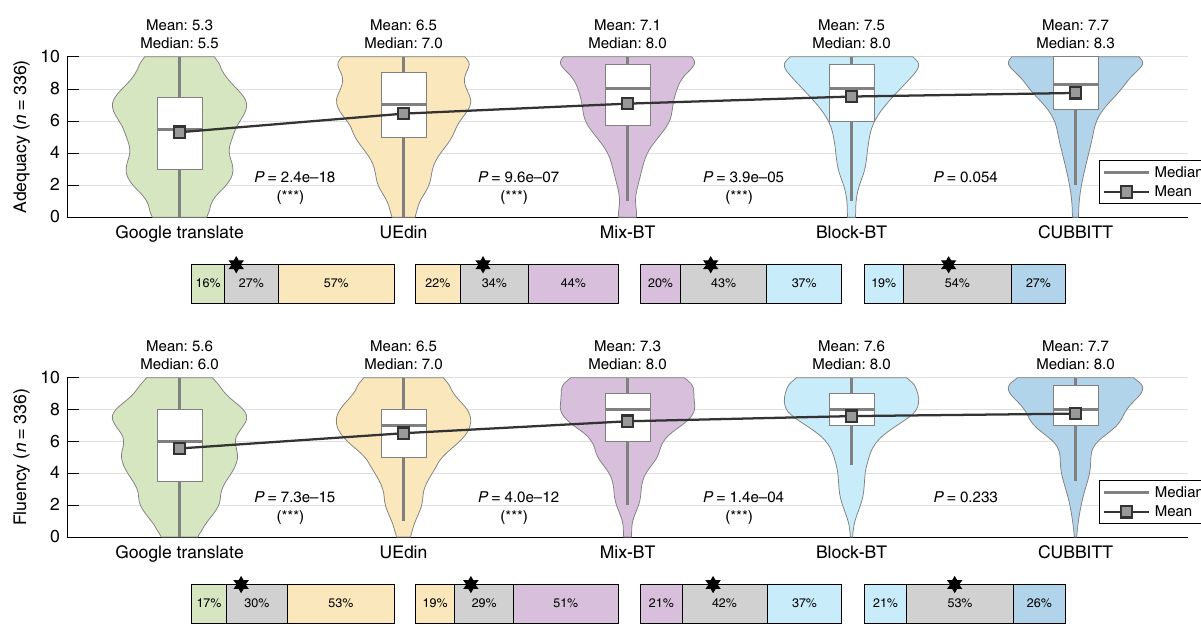
Fig. 4 Types of errors made by CUBBITT versus human and a comparison of machine systems. a Percentages of sentences with various types of errors are shown for translations by human reference and CUBBITT. Errors in 405 sentences were evaluated by six evaluators (three professional translators and three non-professionals). Sign test was used to evaluate difference between human and machine translation. b Translations by fi ve machine translation systems were scored by fi ve professional translators in the terms of adequacy and fl uency in a blind context-aware evaluation. The systems are sorted according to the mean performance, and the scores (0 – 10) for individual systems are shown as violin plots with boxplots (median + interquartile range). For each pair of neighboring systems, the box in between them represents the percentage of sentences scored as better in one, the other, or the same in both (gray). The star symbol marks the ratio when ties are ignored. Sign test was used to evaluate difference between the pairs of MT systems. *** P < 0.001; ** P < 0.01; * P <